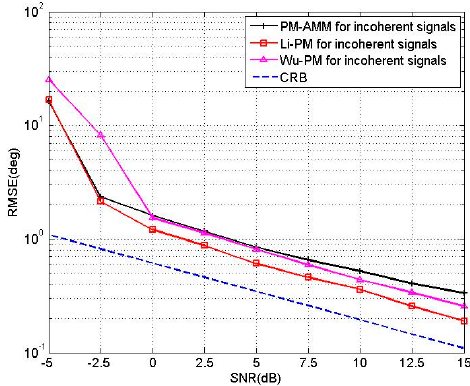
Figure 5. 2D DOA estimation results of PM-AMM algorithm. ( a ) Three signals with different elevation and azimuth angles; ( b ) Two signals with the same azimuth angles.